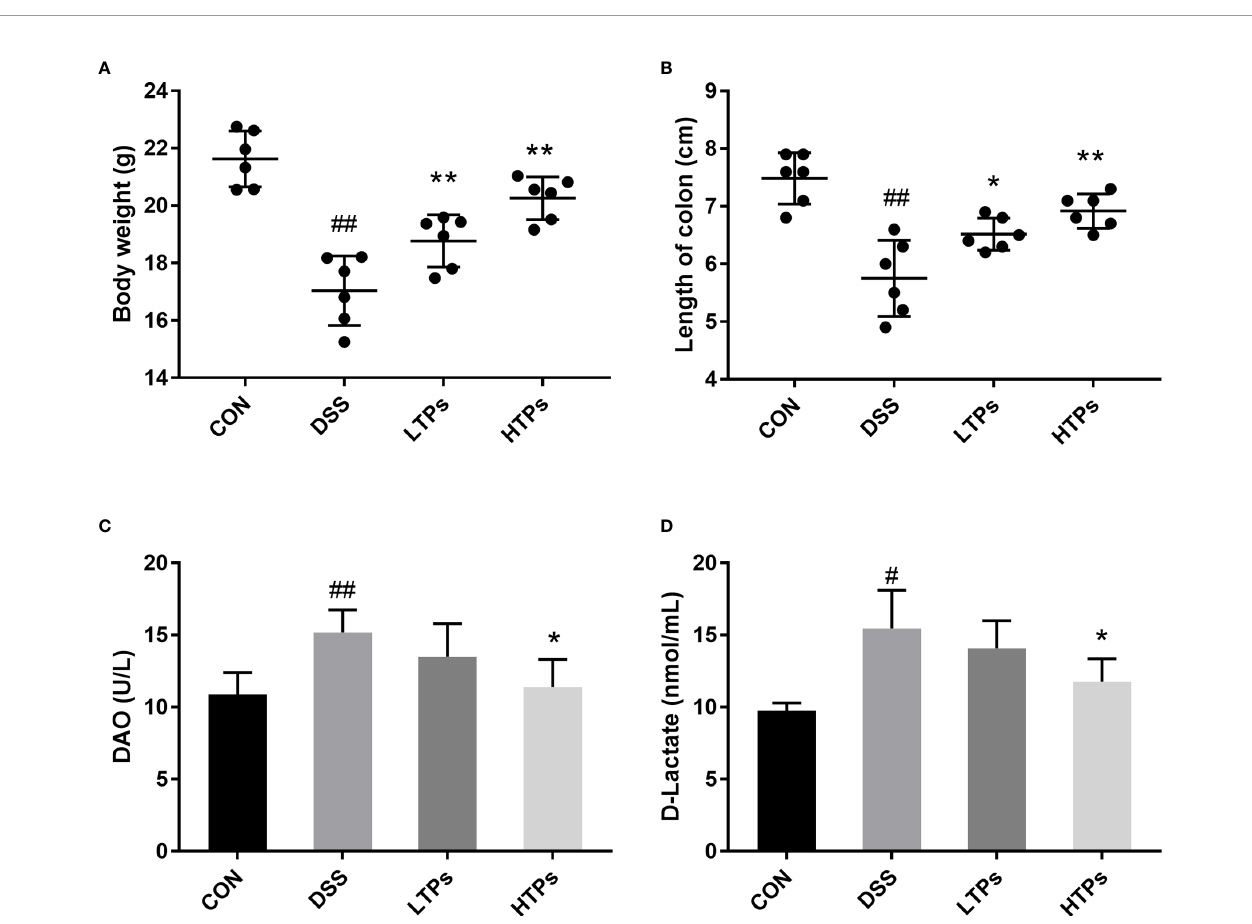
FIGURE 2 | TPs ameliorated DSS-induced clinical symptoms in mice. (A) Bodyweights of mice were measured after the experiment. (B) Length of colon. (C) DAO activity in serum. (D) D-lactate concentration in serum. CON, Control group; DSS, DSS challenge group; LTPs, DSS challenge + 200 mg/kg TPs; HTPs, DSS challenge +300 mg/kg TPs. All values are represented as mean ± SD ( n = 6). # p < 0.05, ## p < 0.01 v . normal group. * p < 0.05, ** p < 0.01 v . control